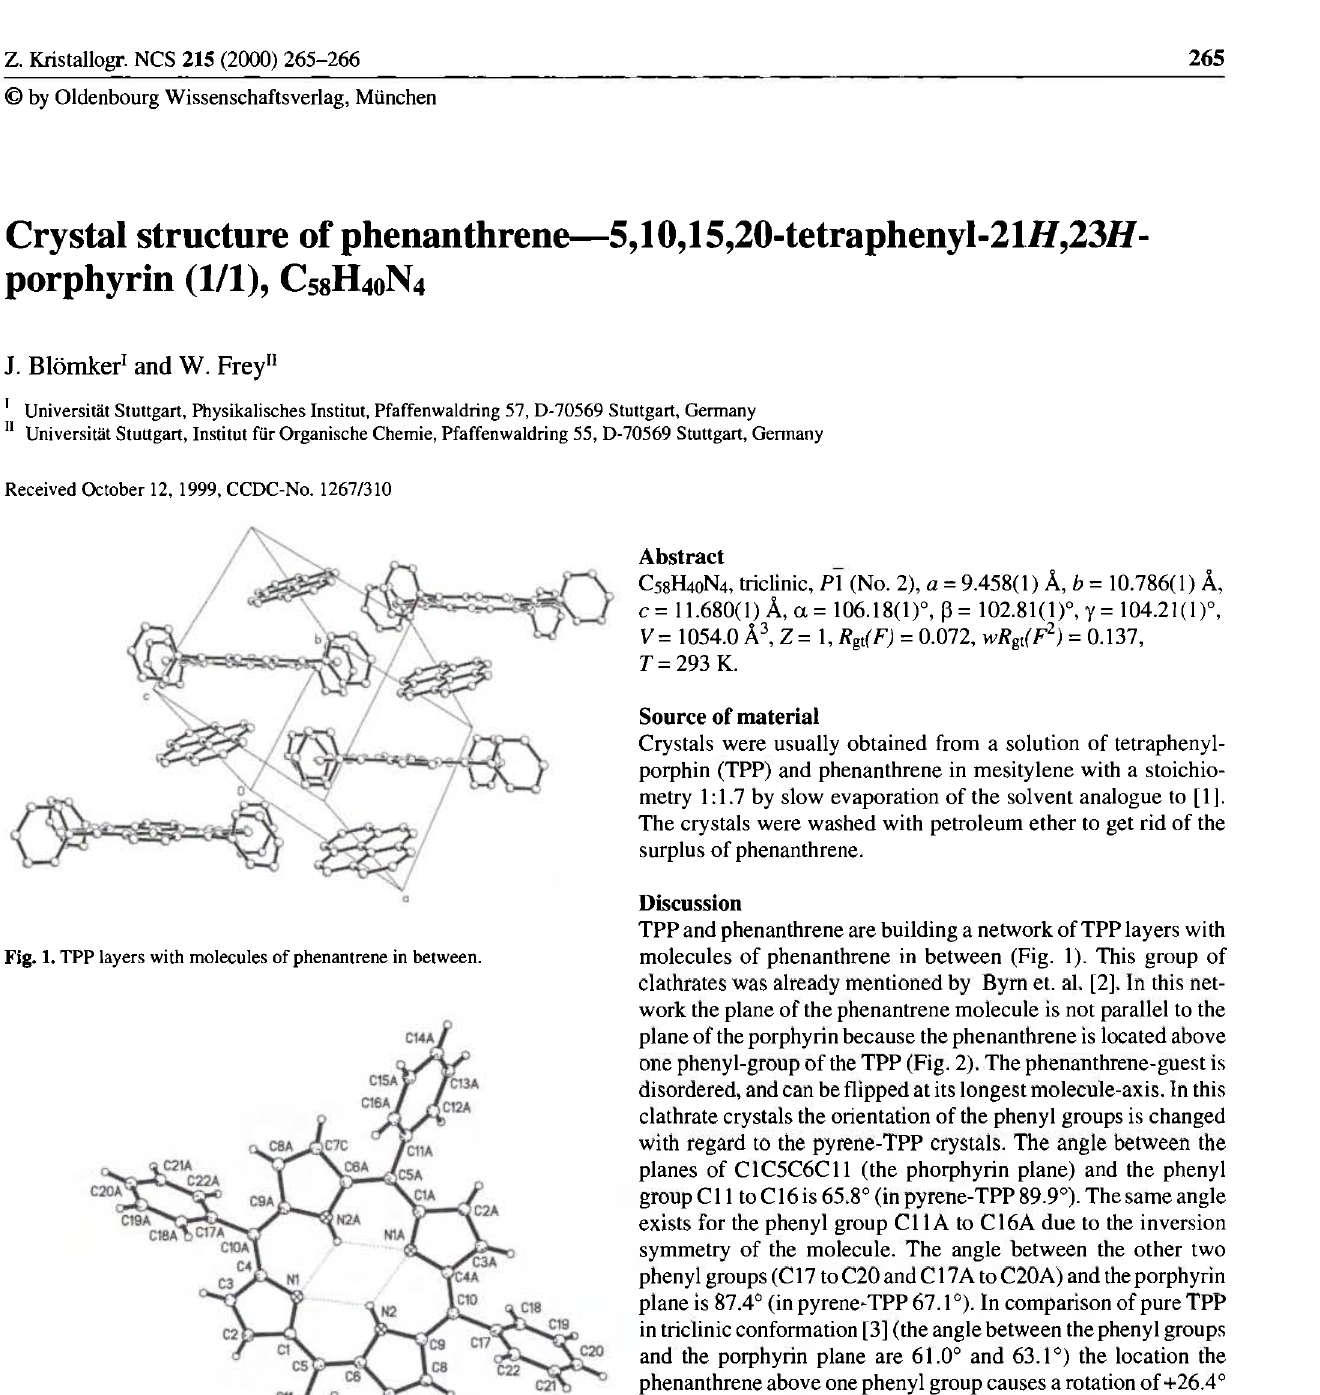
Table 1. Data collection and handling.